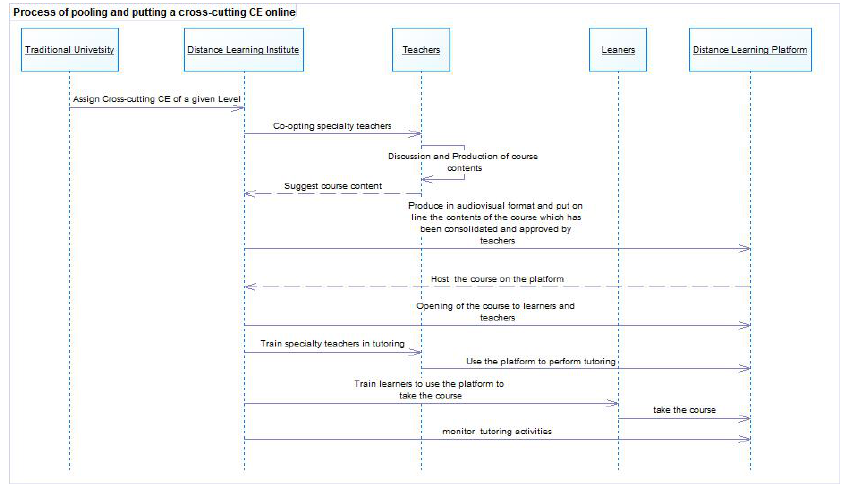
Fig. 3. Process for pooling and putting a cross-cutting component